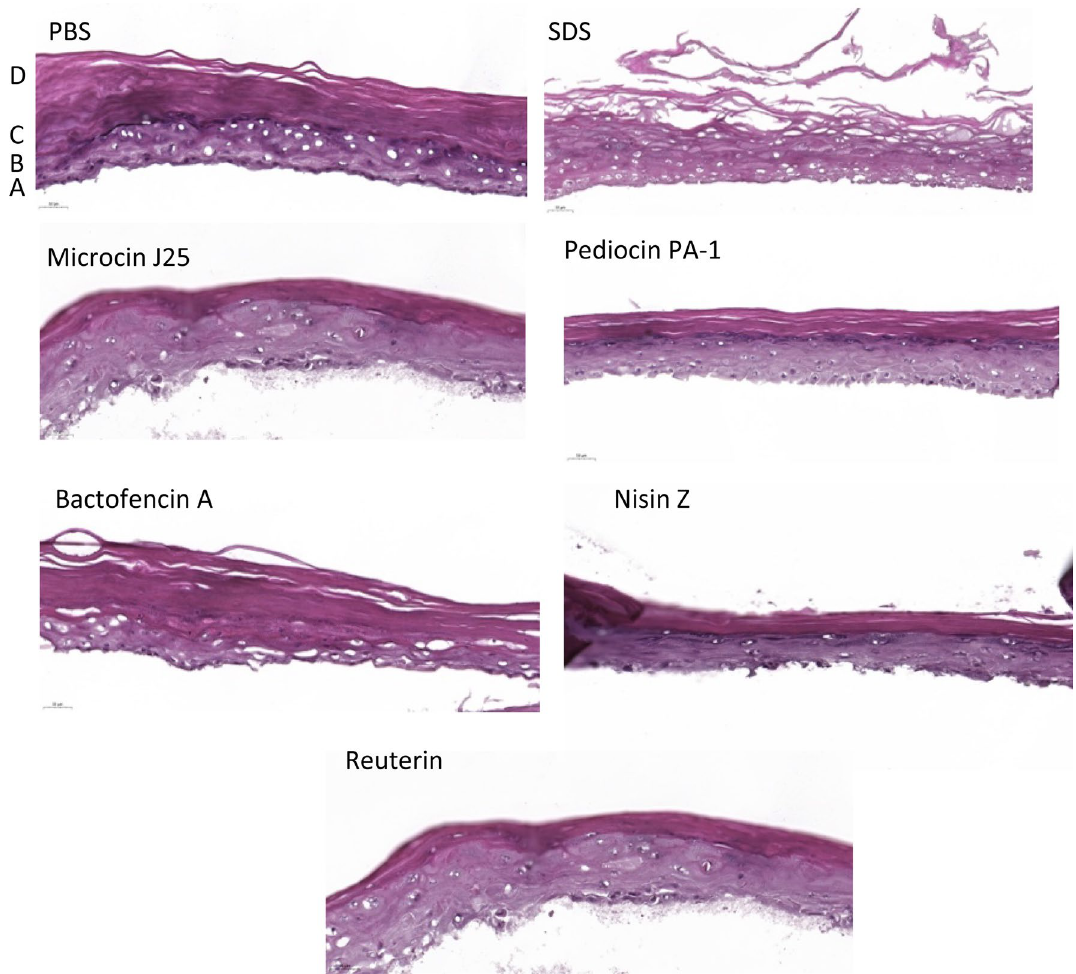
Figure 6. Histological analysis of skin tissue after exposing them to 200 µg/mL microcin J25, pediocin PA-1, bactofencin A, and nisin Z and 40 mg/mL reuterin. ( A ) Stratum basal membrane, ( B ) stratum spinosum, ( C ) stratum granulosum, ( D ) stratum